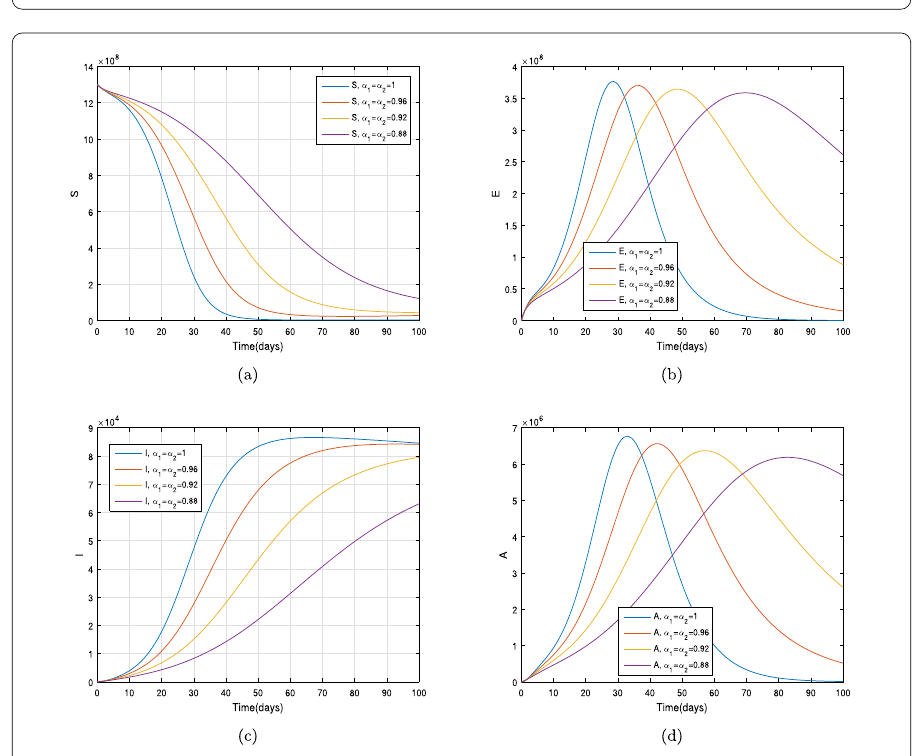
Figure 13 The dynamics of the model variables for α 1 = α 2 = 1,0.96,0.92,0.88, subfigures (a)–(d) respectively represent the susceptible, exposed, infected, and asymptomatic